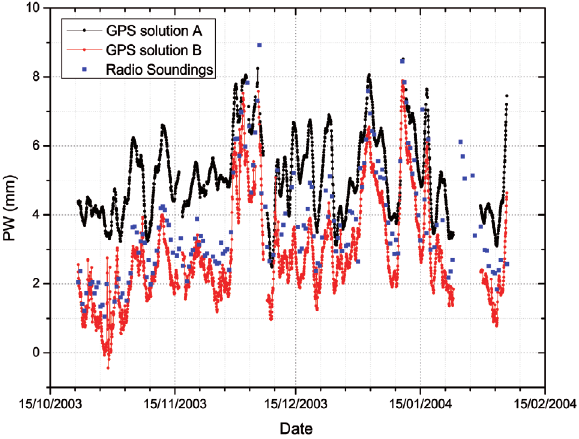
Figure 10. Precipitable water ratios between GPS solution A and the precipitable water derived by the radiosoundings (green), and the pre- cipitable water from solution B and the radiosoundings (red). Solid lines, second-order (green) and first-order (red) interpolating functions.